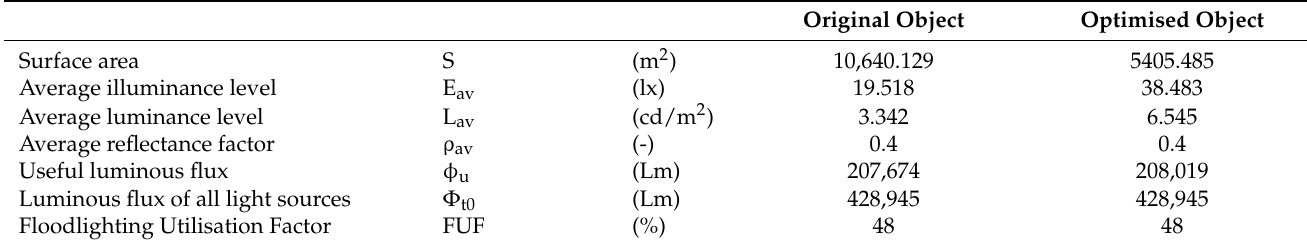
Table 1. The calculated surface and photometric parameters for the object before and after its